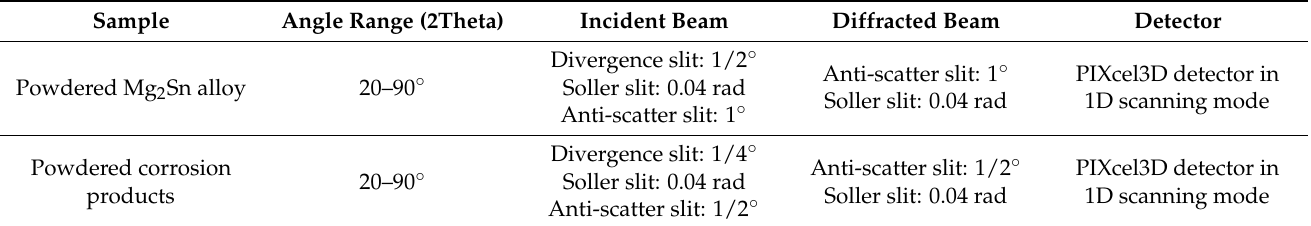
Table 1. XRD measurement